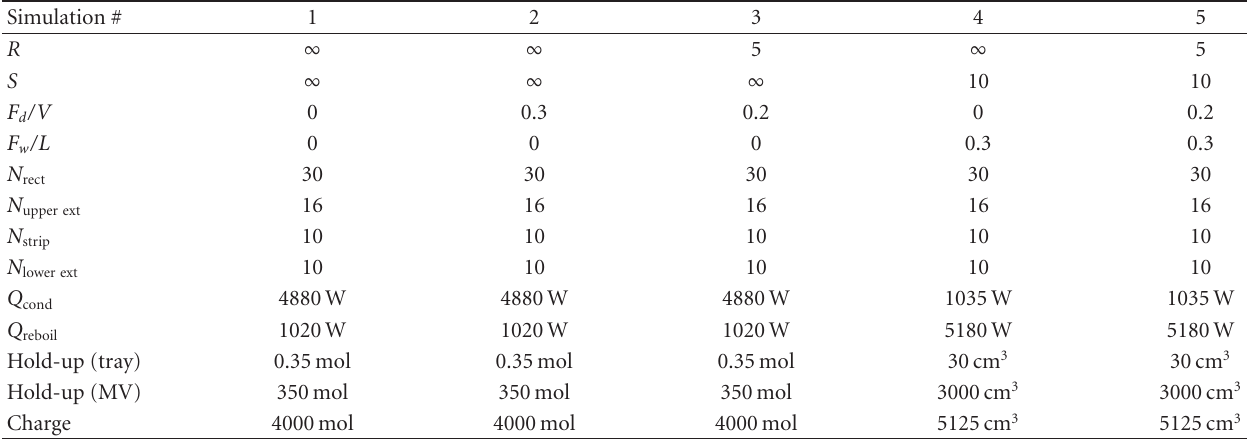
Table 7: Parameters of the simulations with ProSimBatch.